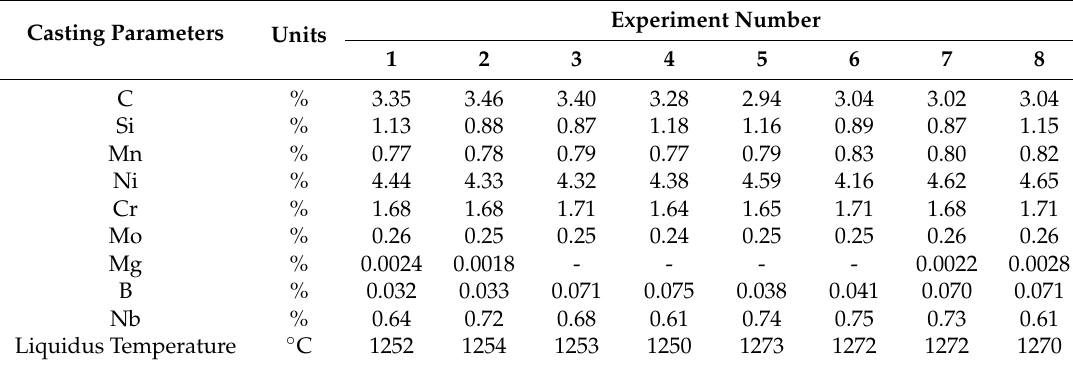
Table 5. Casting parameters in each